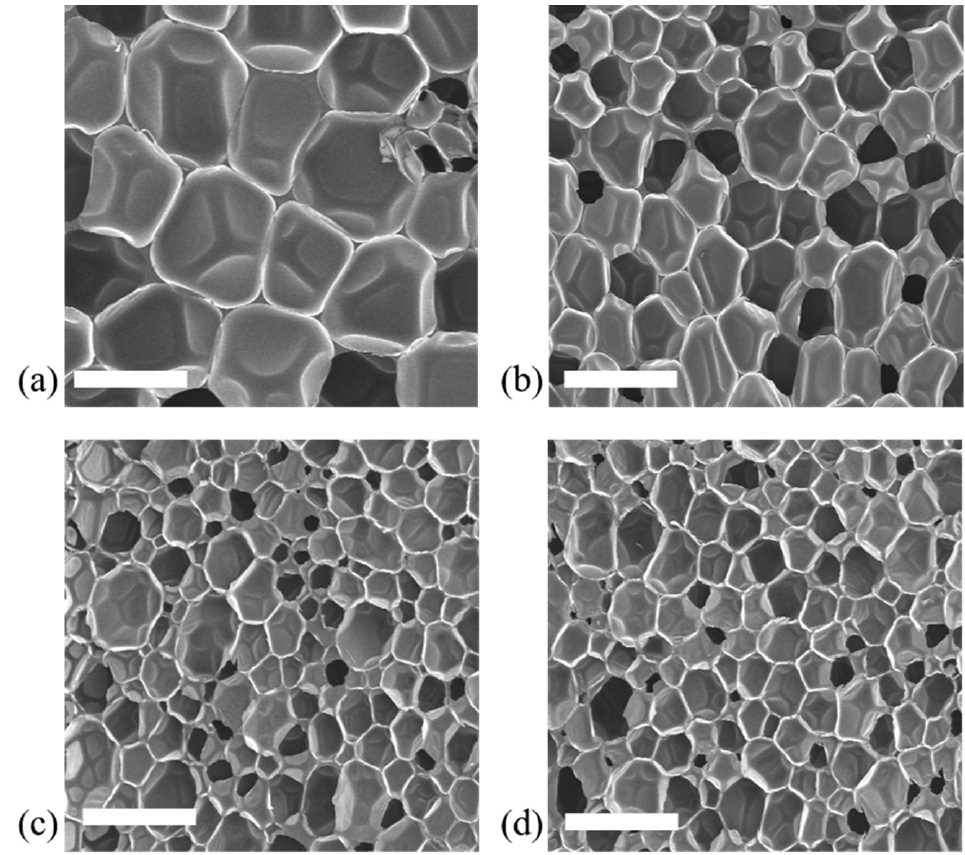
Figure 7. SEM micrographs of PU samples obtained at ( a ) 50, ( b ) 500, ( c ) 1000 and ( d ) 2000 rpm. Scale bars are 200 µm.